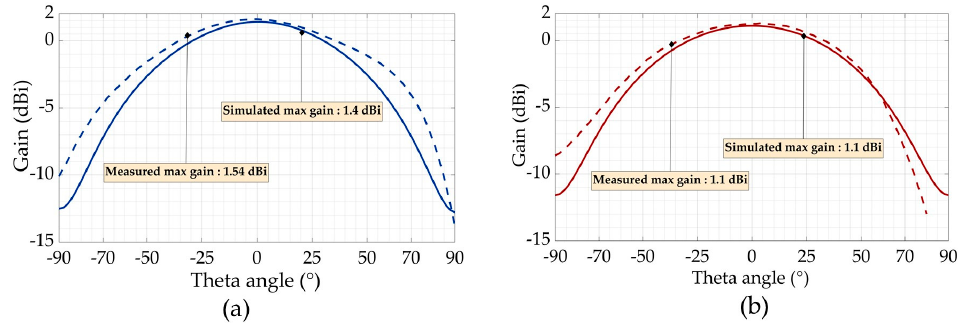
Figure 11. Simulated (dashed line) and measured (continuous line) radiation pattern (gain plot in the E-plane): ( a ) AC antenna; ( b ) A2 antenna at the resonant frequency (868 MHz). Table 1 compares in terms of performances and size some state-of-the-art antennas and the presented solution operating in ISM 868 MHz or ISM 915 MHz frequency bands. compared with the substrates used by other state-of-the-art designs. Table 1. Comparison with the different compact antennas for rectenna of IoT devices in the state of the art. Ref. Freq. (MHz)